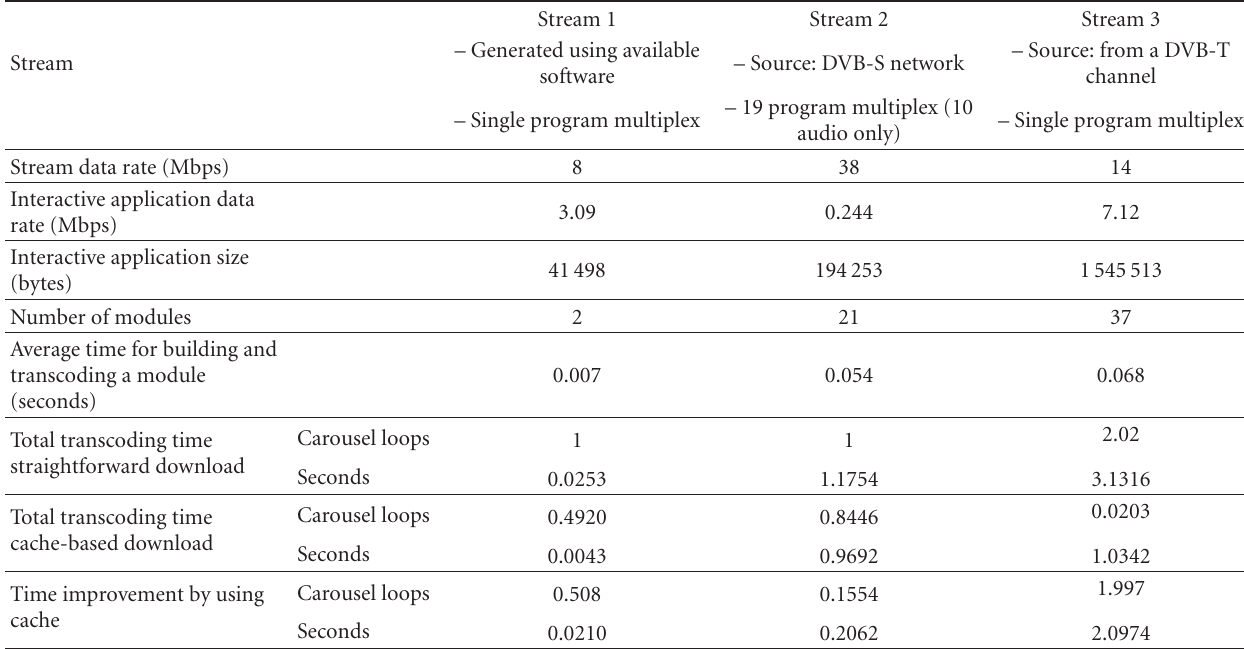
Table 9: Test results of the interactive data